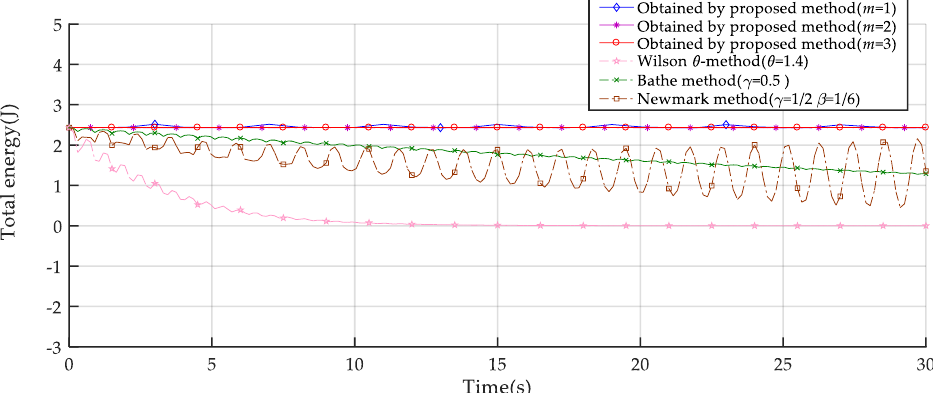
Figure 9. Comparisons of energy responses among the Newmark method, Wilson method, Bathe method, and the present method.